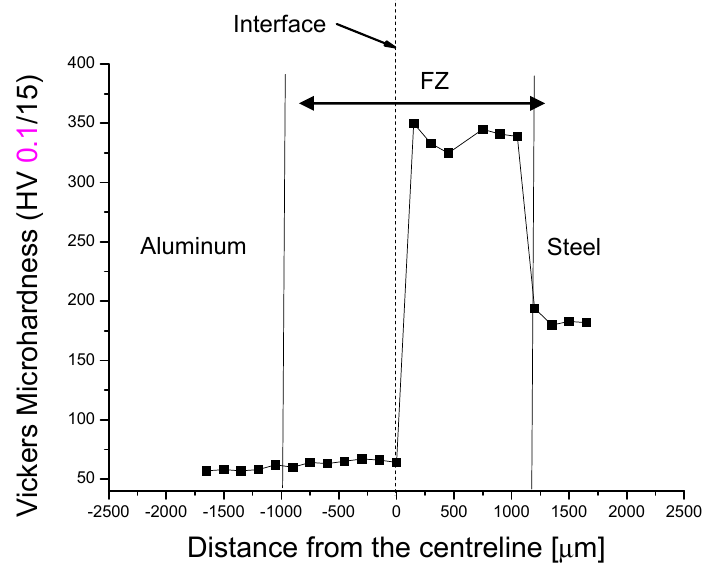
Figure 20. Cross weld section microhardness profile for the hybrid laser-MIG.